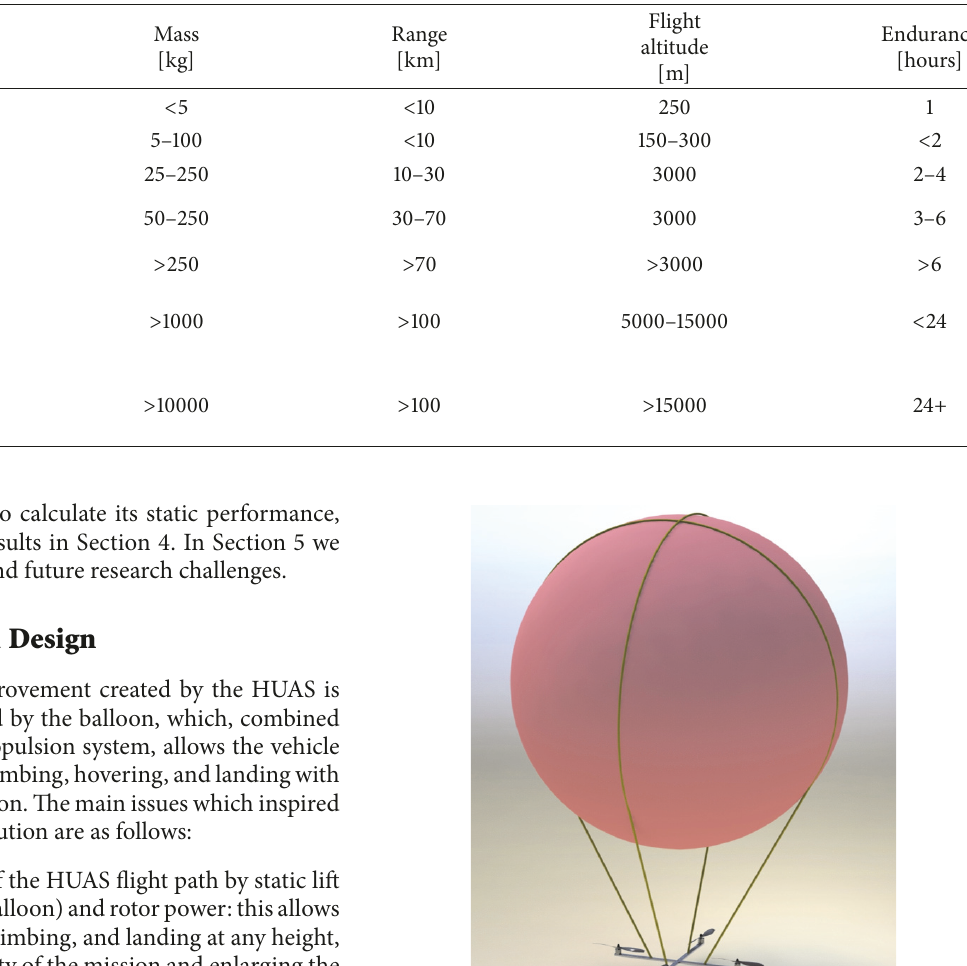
Table 3: UAS classification based on mass, distance covered, altitude, and flight endurance [5].